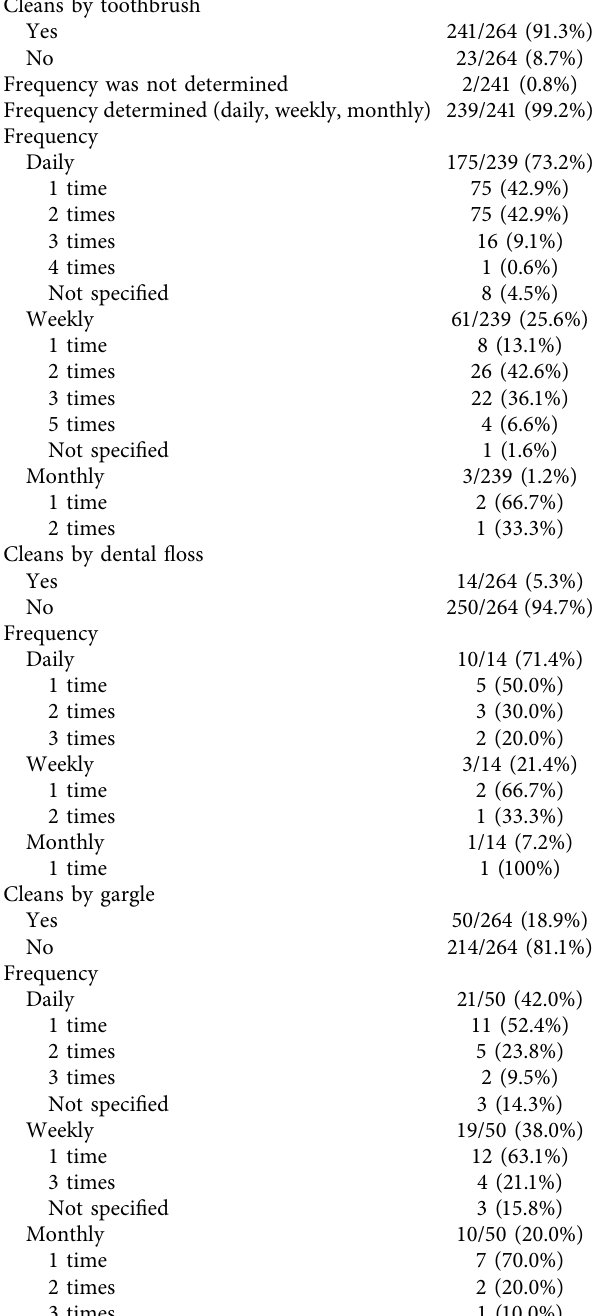
Table 4: Methods of dental hygiene practiced by the mothers. Cleans by